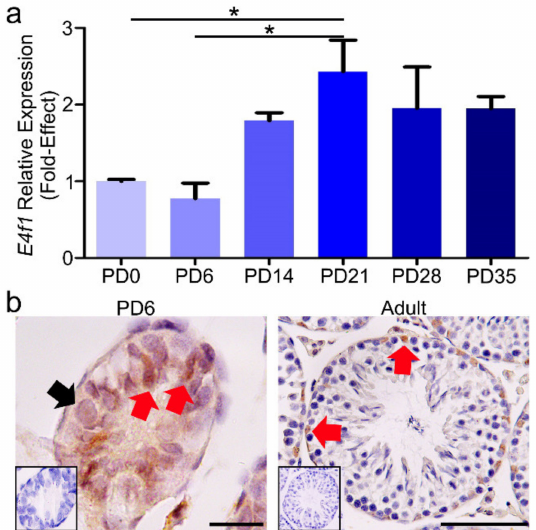
Figure 1. The relative mRNA expression and protein localization of E4F1 in postnatal mouse testes. ( a ) Quantification of mRNA expression of E4f1 in testes of mice at di ff erent development stages. Data were analyzed by mean ± SEM for 3 mice per stage. * denote significantly at p < 0.05. ( b ) Immunohistochemical staining of E4F1 in testes at PD6 (scale bar = 20 µ m) and adult (scale bar = 1 00 µ m) male mice. Black arrow indicates spermatogonia and red arrow indicates Sertoli